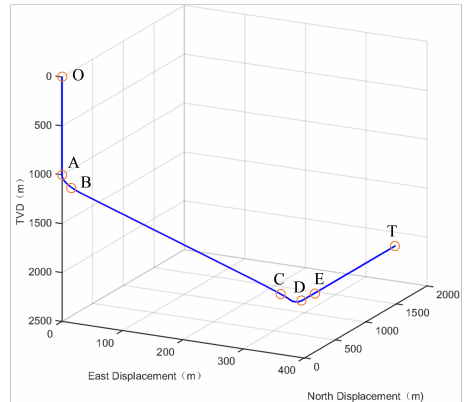
Fig. 1. Six-section well profile of three-dimensional horizontal